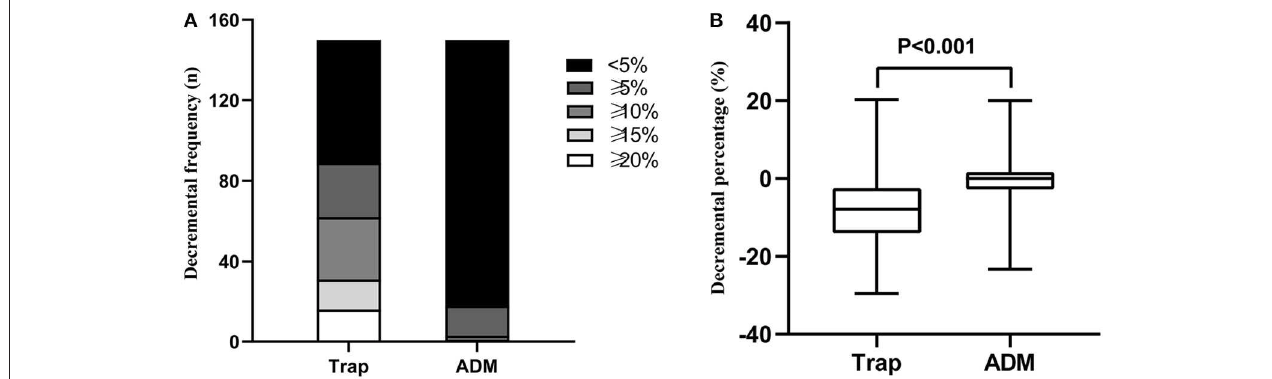
Frontiers in Neurology |